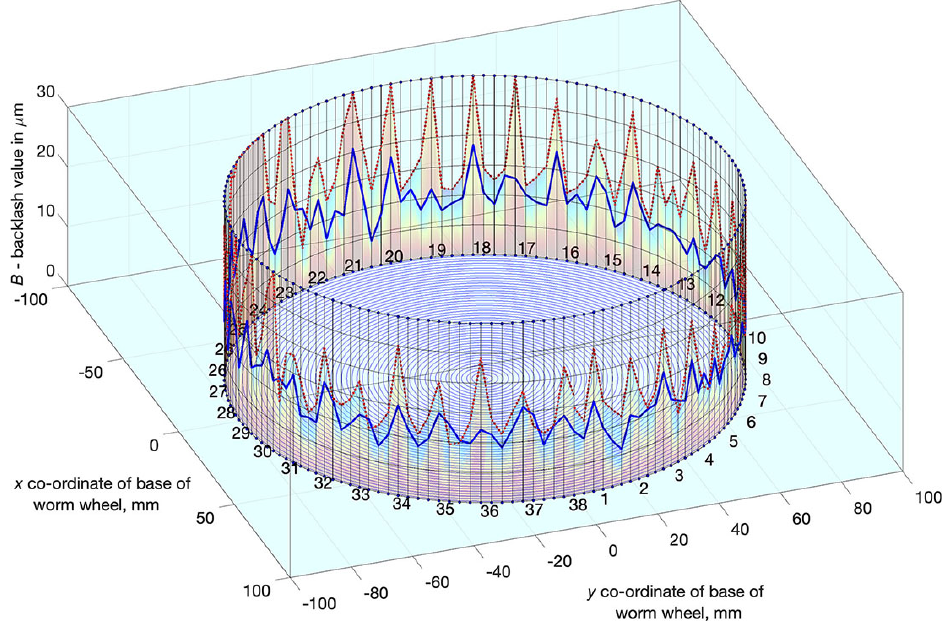
Figure 17. Backlash for positions of successive worm wheel teeth in the centre of the meshing zone; the red line represents backlash values before adjustment; the blue line—after adjustment.